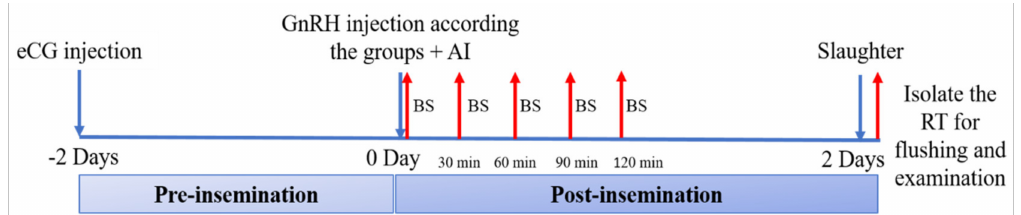
Figure 1. Experimental planning of trial 1, aiming to determine the effect of gonadotrophin-releasing hormone (GnRH) in different doses and routes of administration on LH secretion (by means of successive blood samples; BS) and presence of oocytes/embryos in the reproductive tract, RT, at day 2 after artificial insemination